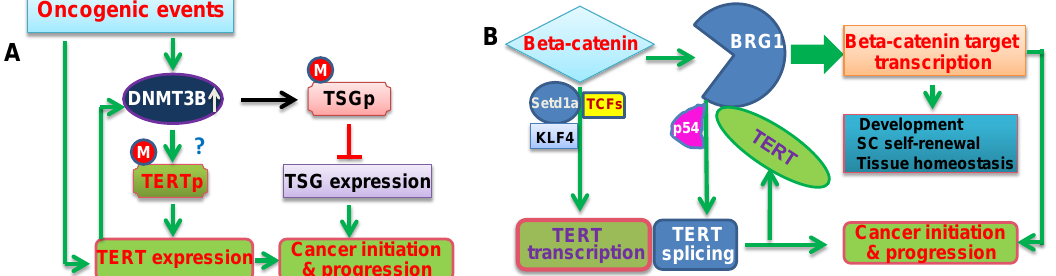
Figure 2. The schematic illustration of cross-talks between TERT and epigenetic factors. ( A ) The positive feedback loop between DNMT3B and TERT. Oncogenic events lead to the aberrant up-regulation of DNMT3B expression, thereby triggering the hypermethylation of the promoters in tumor suppressor genes (TSGs) and repression of these TSGs. On the other hand, DNMT3B over-expression may result in the TERT promoter hypermethylation, and consequently, activates TERT transcription. TERT induction in turn further up-regulates DNMT3B expression, which forms a positive feedback loop between them, and amplifies the oncogenic signaling to promote cancer initiation and progression. M: Methylated. ?: Not conclusive. ( B ) The positive feedback loop between β -Catenin and TERT. β -Catenin directly activates TERT transcription, while TERT acts as a co-factor to promote the transcription of the β -Catenin target genes by recruiting BRG1, which results in the formation of their positive feedback loop. In addition, BRG1 and P54 (nrb) cooperate to regulate TERT splicing and promote the generation of the full-length TERT mRNA. All these interactions play an important role in both physiological activities and